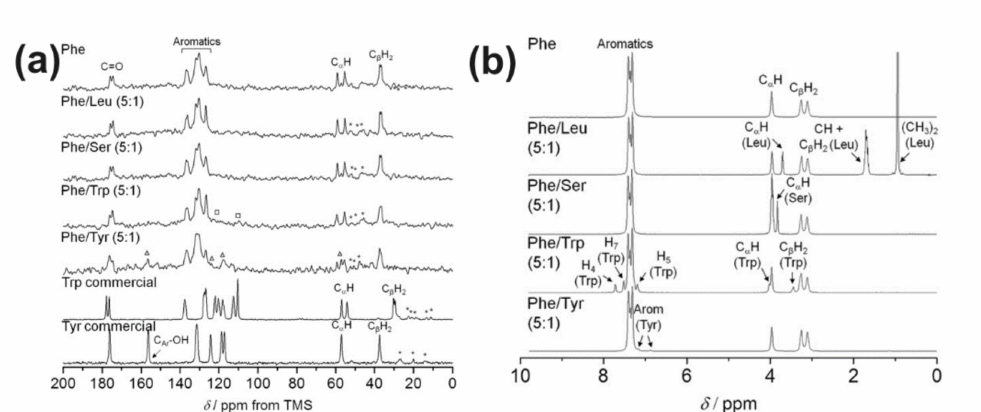
Figure 2. ( a ) Multiple solid-state NMR spectra of phenylalanine hydrogels, two-component hydro- gels, and starting materials arranged for comparison. ( b ) Solution-state NMR spectra of phenylalanine hydrogels and two-component hydrogels with different amino acids added. Abbreviations: pheny- lalanine (Phe), leucine (Leu), serine (Ser), tryptophan (Trp), and tyrosine (Tyr). Reproduced under the terms of the Creative Commons Attribution License from [25]. ©2017 The Authors. Published by Wiley-VCH Verlag GmbH & Co.